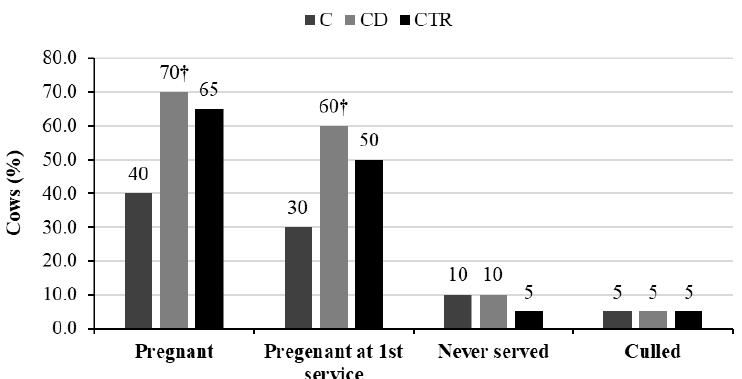
Figure 4. Percentages of cows pregnant, pregnant at first service, never served, and culled within 120 days in milk over the total number of cows ( n = 20) included in each of the three treatment groups (C = ceftiofur; CD = ceftiofur + ketoprofen; CTR = control). † Values of groups C and CD differed at p < 0.10. Even if CD cows seemed to show better performances regarding the number of services per cow and per pregnancy within 120 DIM than C ones, no statistically significant differences were detected amongst groups (Table